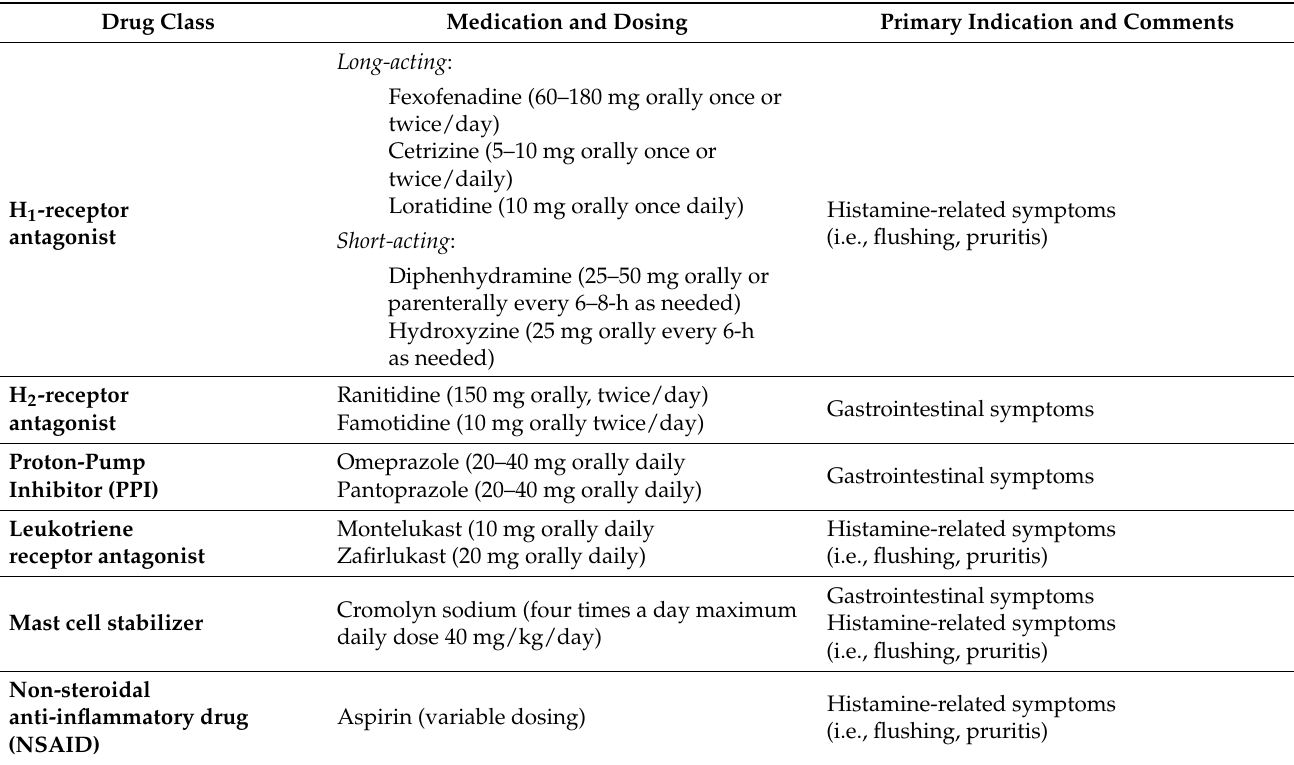
Table 2. Medical Management of Mast Cell